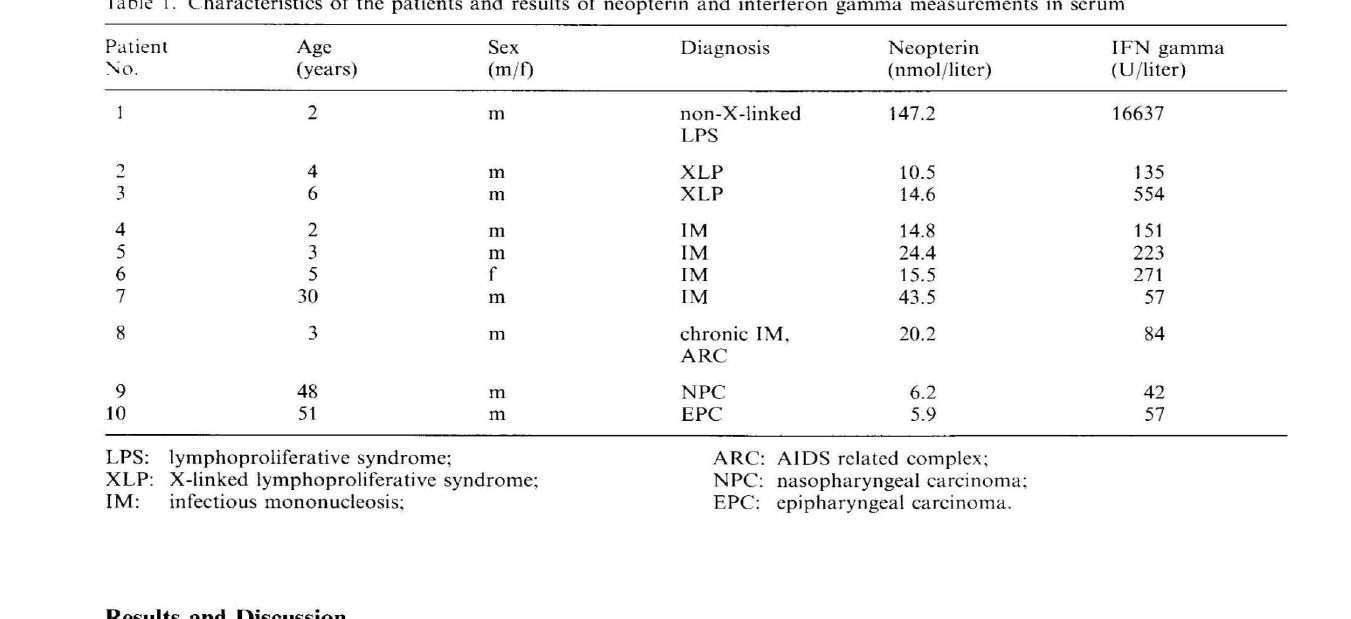
Table 1. Characteristics of the patients and results of neopterin and interferon gamma measurements in serum Patient ,,"0.